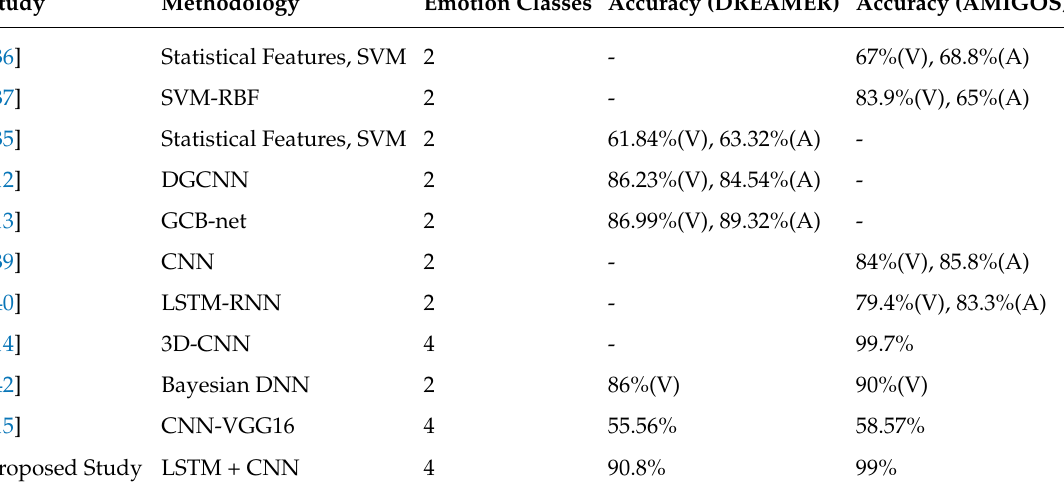
Table 13. Comparison with state-of-the-art related work. V and A represents binary classification (High or Low) of Valence and Arousal respectively, while 4 classes are HVHA, HVLA, LVHA and